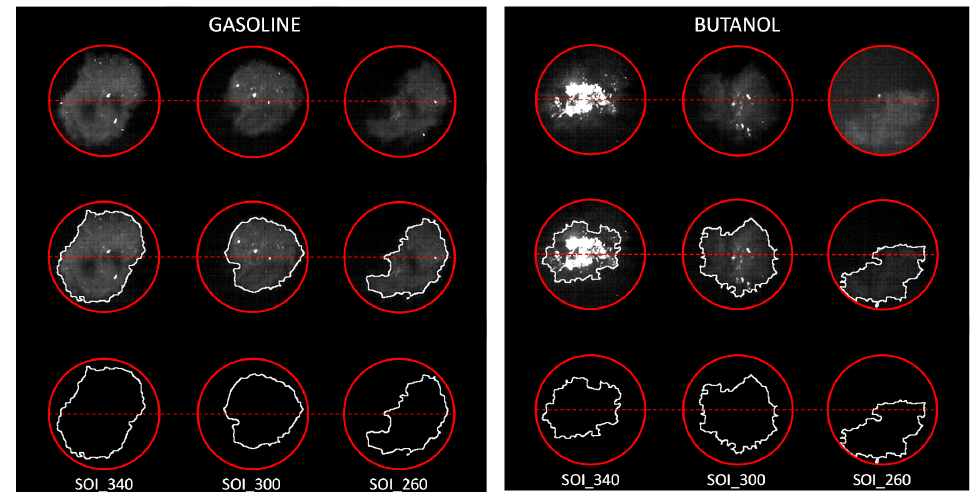
Figure 9. Flame images and related contours at roughly the same flame area (i.e., around 10% MFB).